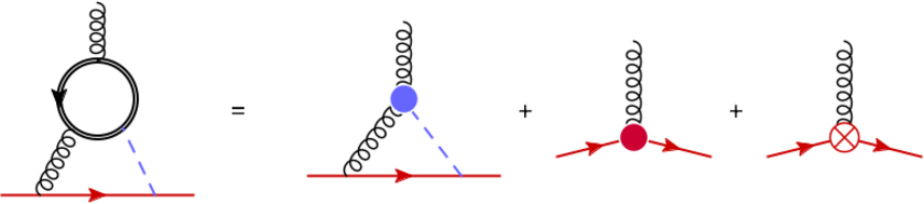
Figure 6 . Two-loop matching to determine the coe(cid:14)cient C tG at two-loop accuracy. and perform the calculation. With the correct mixing